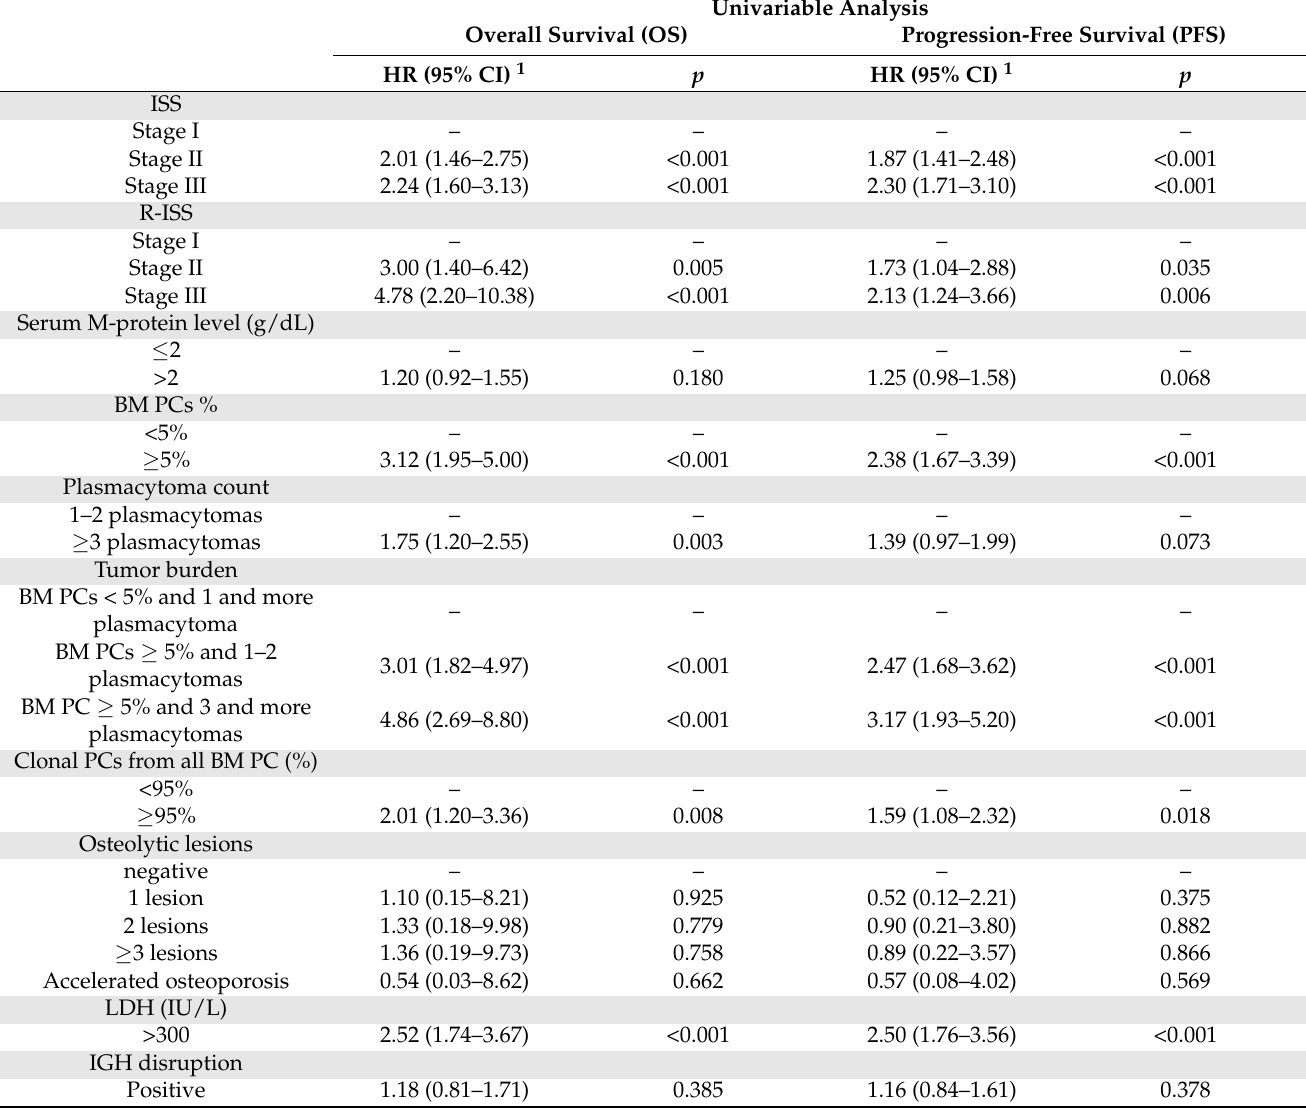
Table 1. Association of clinical features with OS and PFS in NDMM patients with PS plasmacytomas. Univariable